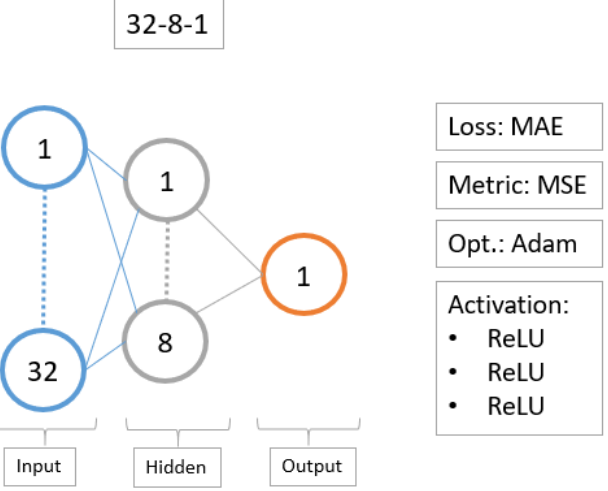
Figure 14. Selected network architecture. Source: Own elaboration. Soc. Sci. 2021 , 10 , x FOR PEER REVIEW